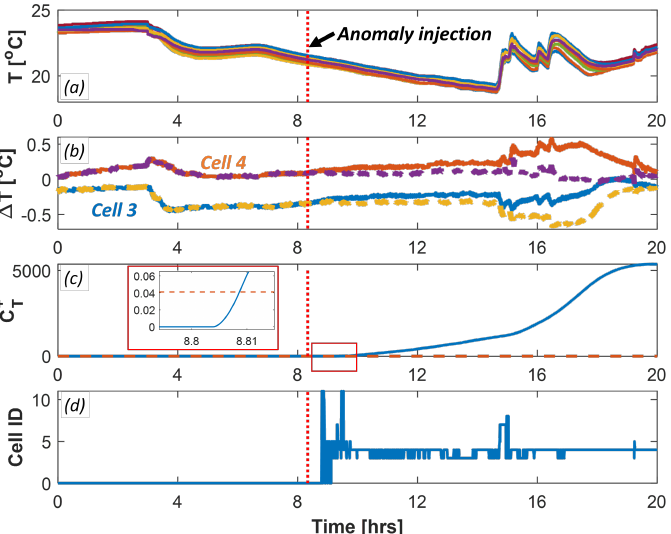
Figure 7. Detection of air–flow anomaly ( ϑ = 0.2), leading to anomalous temperatures in cells 3 and 4, with anomaly initiation (dotted) at 8.33 hours, using PCA method: ( a ) Temperature of 11 cells and mean temperature (dashed); ( b ) Nominal (dashed) and anomalous (solid) temperature MBR of cells 3 and 4; ( c ) Temperature anomaly score from PCA method with threshold (dashed); and ( d ) PCA method tracing of anomalous